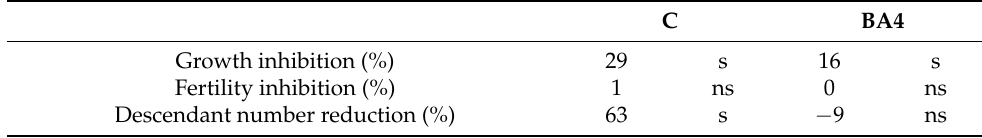
Table 4. Inhibition of growth, fertility, and reproduction in untreated (C) and BA4-treated soil in comparison to the standard soil LUFA (mean value of